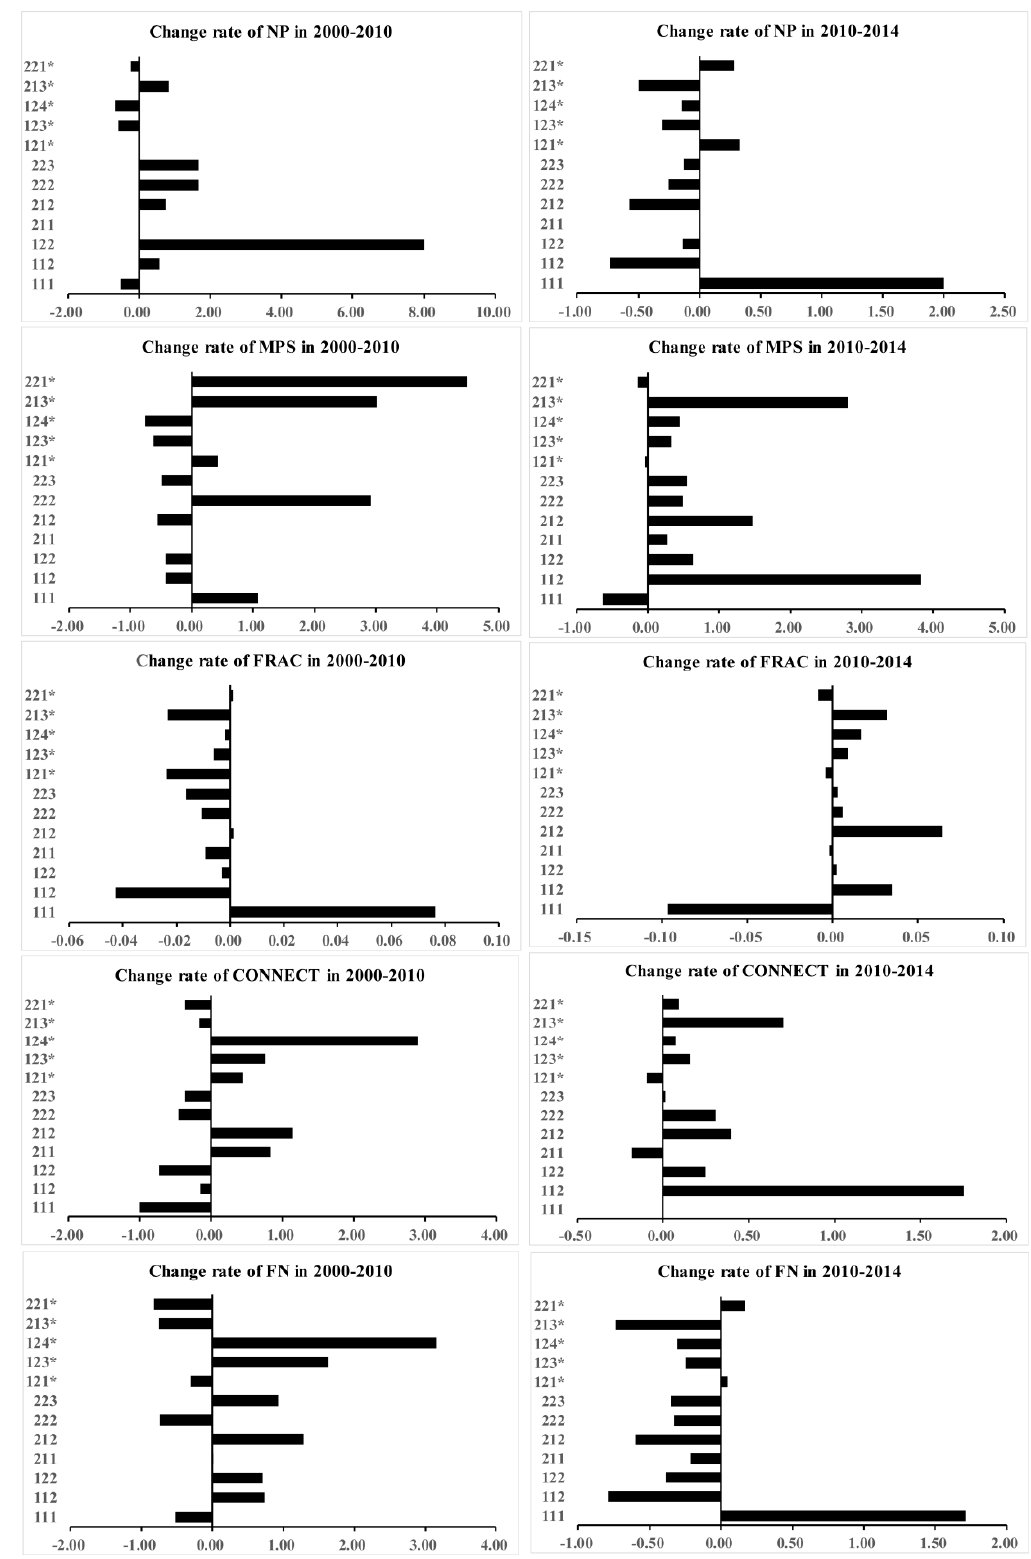
Figure 5. Change rate of forest landscape indices for each community in 2000–2010 and 2010–2014. * indicates communities that implemented RFFP. Refer to Table 3 for the abbreviations for landscape metrics. Table 6. Comparison of forest landscape indices between RFFP and non-RFFP communities.